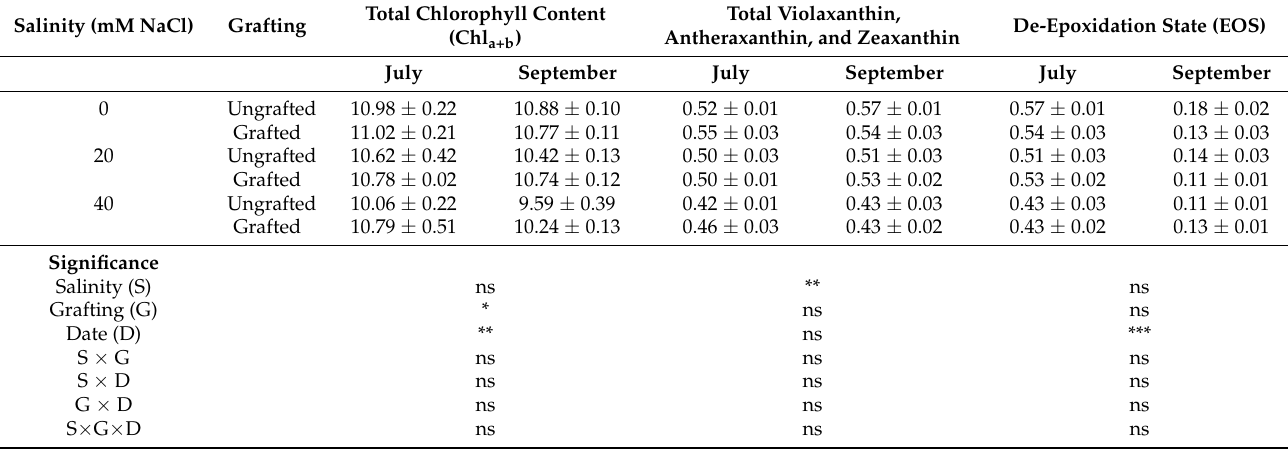
The photosynthetic pigments in the pepper leaves were analyzed in July and Septem- ber 2018. Compared to the control (0 mM NaCl), the increased salt stress did not affect the total chlorophyll content (Chl a+b ) in these pepper leaves, although there was a significant impact of salt stress duration on Chl a+b ( p = 0.0050). This was reflected in decreased Chl a+b in the pepper leaves with the higher salt stress (40 mM NaCl), which was more evident with the longer duration of the treatments in September. At that time, the ungrafted plants had lower Chl a+b compared to the grafted plants, with these differences reaching marginal significance ( p = 0.060) (Table 4). Table 4. Effects of salt stress on photosynthetic pigment characteristics and xanthophyll cycle components measured in July and September for ungrafted and grafted bell pepper plants, and their salinity, grafting, and date interactions. Total Chlorophyll Content Total Violaxanthin, Salinity (mM NaCl) Grafting (Chl a+b ) Antheraxanthin, and Zeaxanthin